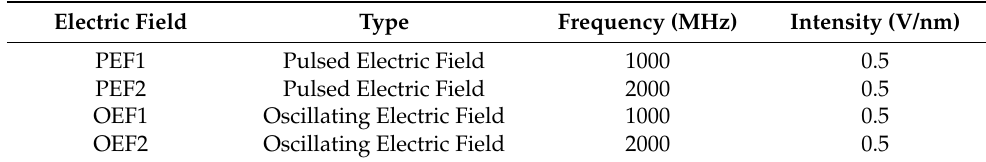
Table 3. Parameters of electric